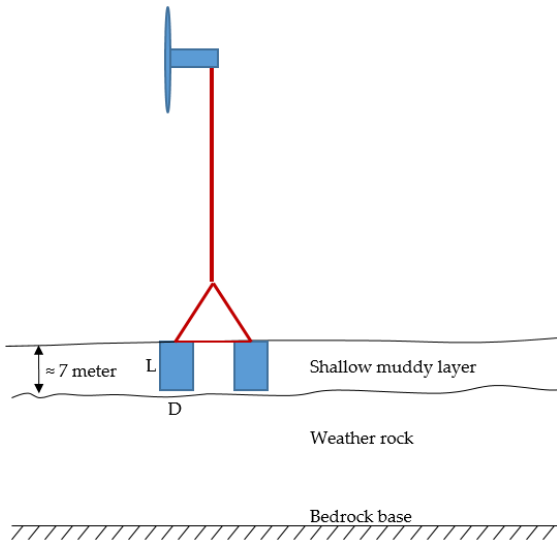
Figure 7. Bucket height (L) was limited by the rock layer depth.